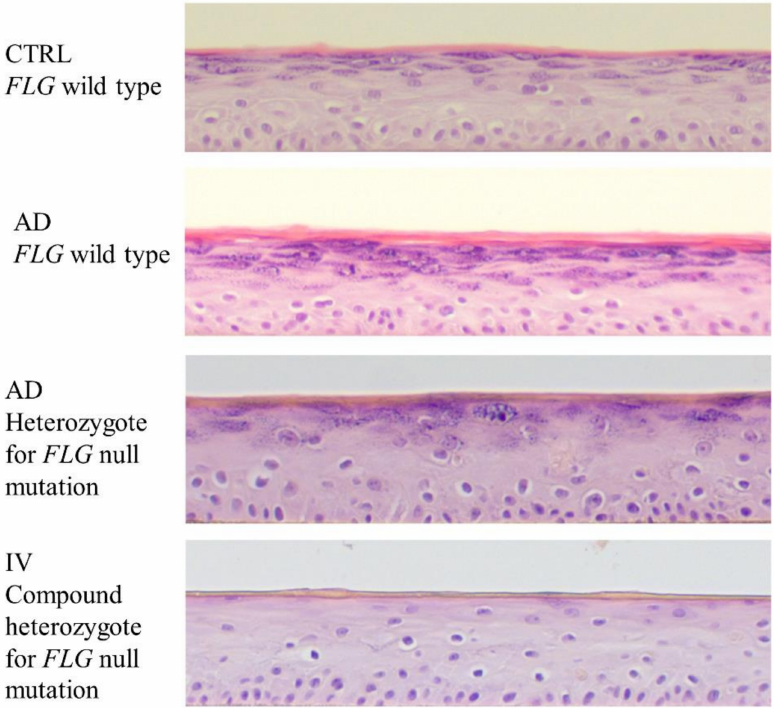
Figure 1. Morphology of atopic dermatitis (AD) and ichthyosis vulgaris (IV) human epidermal equivalents (HEEs). Representative images of HEEs generated with keratinocytes from healthy donors (CTRL) and from patients with AD and / or IV stained with hematoxylin and